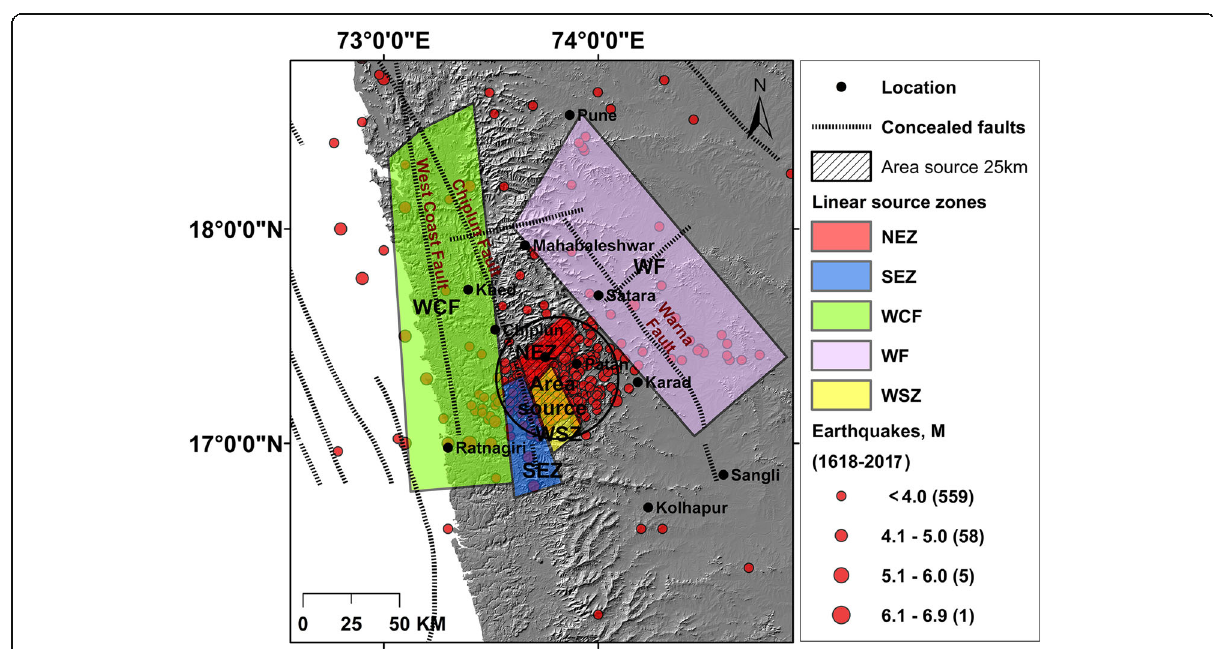
Fig. 7 Seismic source zones of Koyna region (compiled after: Dixit, 2014; Catchings, 2015). NEZ – North escarpment zone, SEZ – South escarpment zone, WCF – West coast fault, WF – Warna fault, WSZ – Warna seismic zone (Fig.